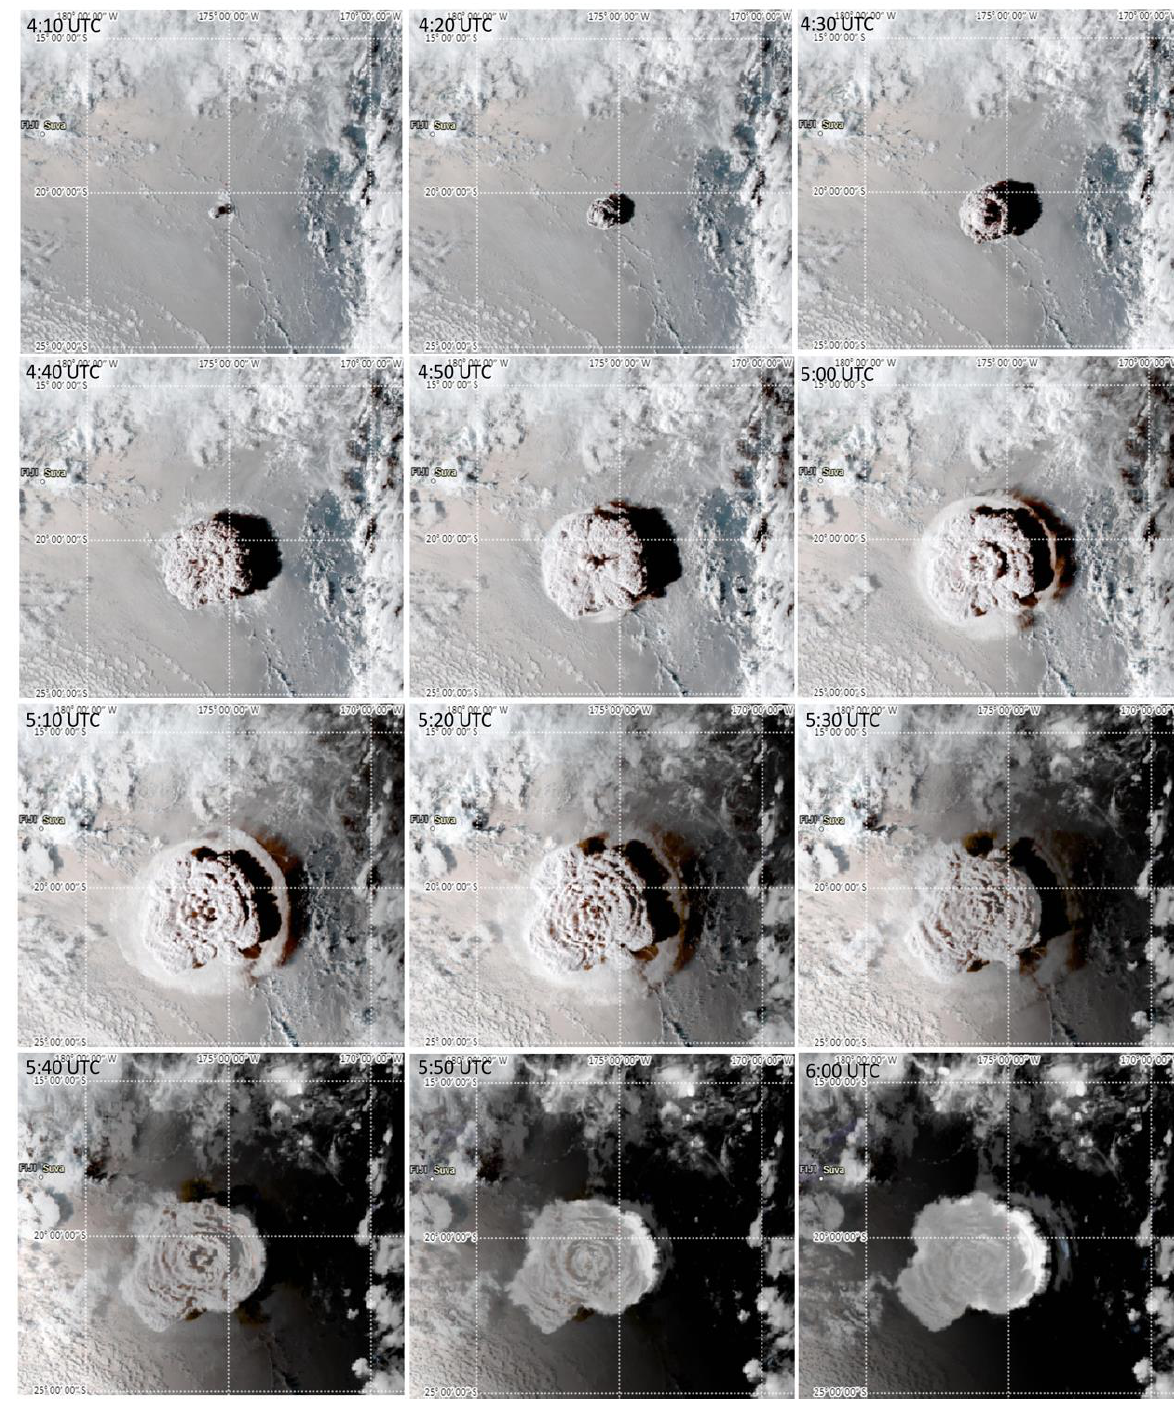
Figure 1. Geostationary Operational Environmental Satellites (GOES)-West satellite (currently, GOES-17) images observed on 15 January 2022.